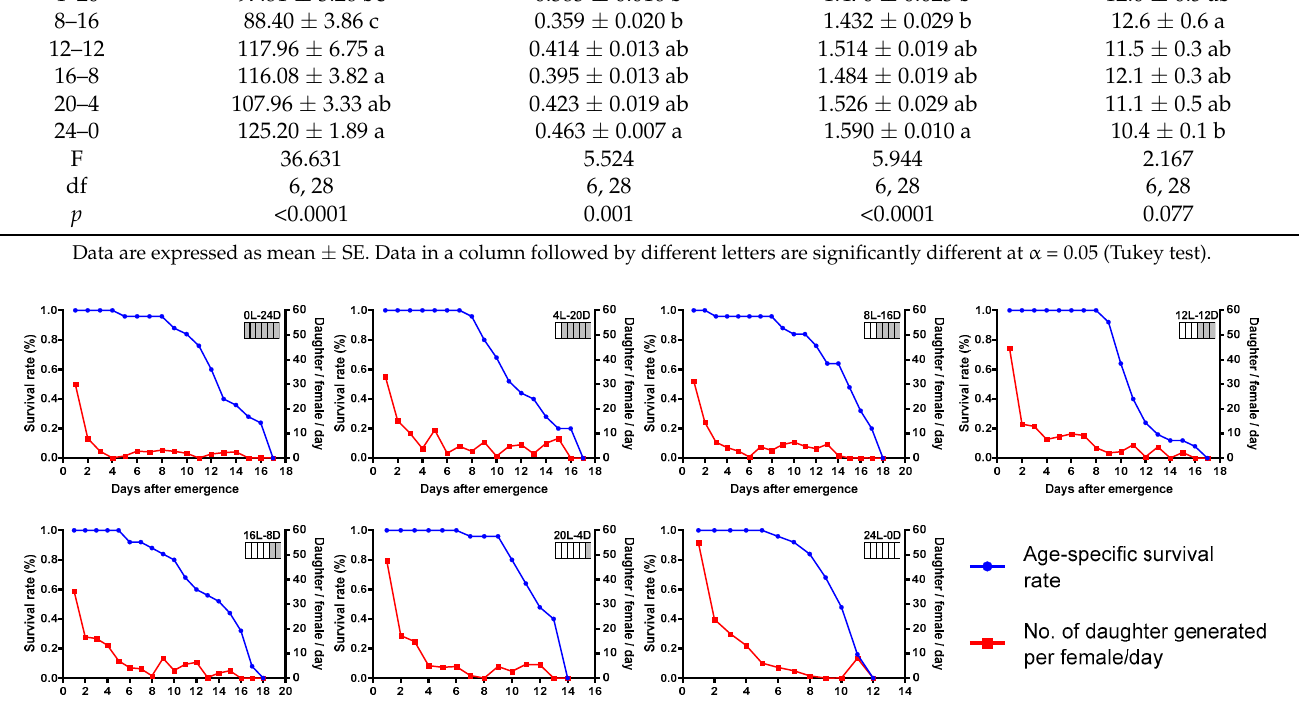
Table 2. Results from ANOVA analysis on the effects of exposure time, host egg:parasitoid ratio,